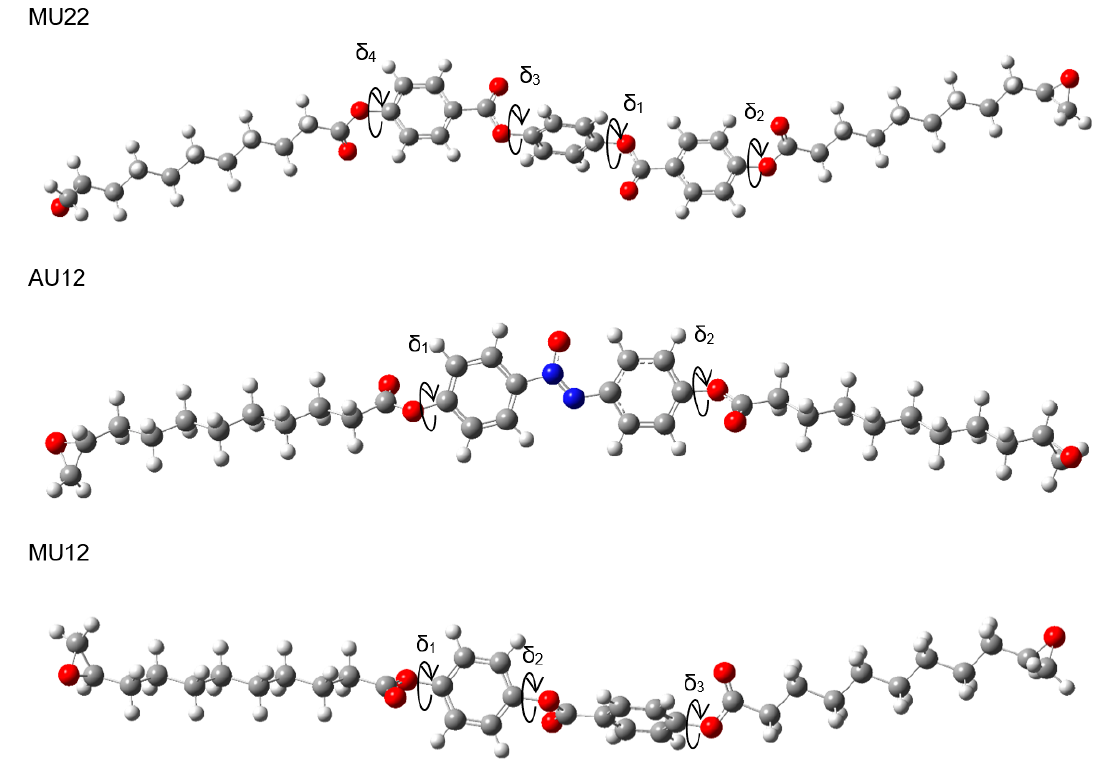
Figure 1. Spatial structure of the three epoxy compounds. Key dihedral angles defining the conformation ( δ i ) are indicated by circular arrows.